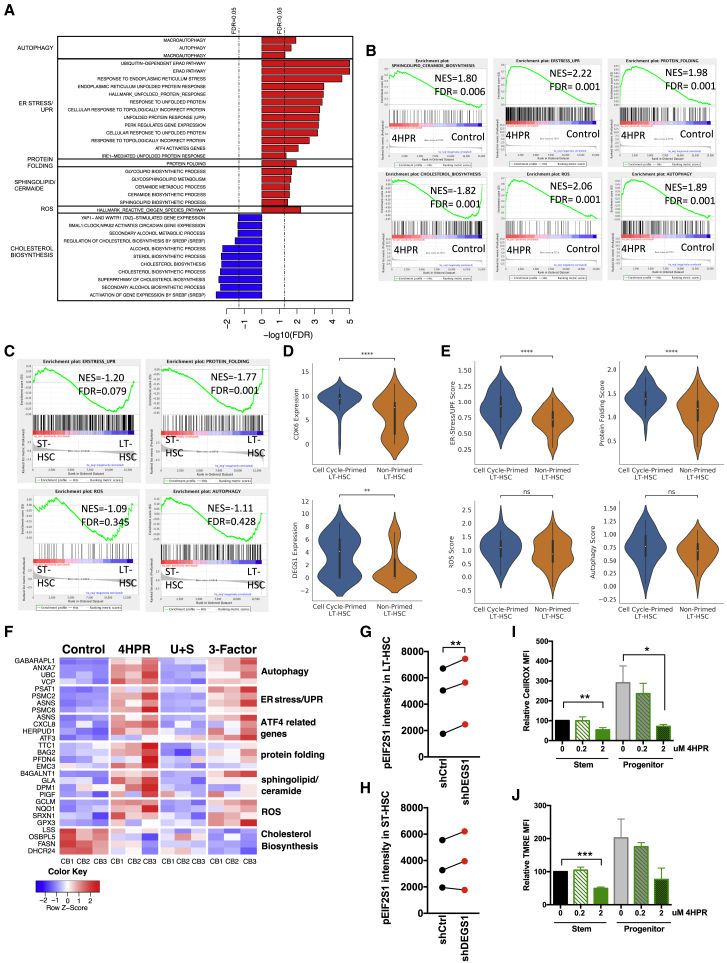
Sphingolipid Modulation with 4HPR Treatment Upregulates Cellular Stress Pathways and Remodels Cellular Metabolism in HSPCs during Ex Vivo Culture(A) NES scores for selected pathways that are significantly enriched following 4HPR treatment at day 2.(B) Pathway analysis (GSEA) of SpL/cer, cholesterol biosynthesis ER stress/UPR, protein folding, and ROS pathway modules for 4HPR compared to control.(C) GSEA analysis of autophagy, ER stress/UPR, protein folding, or ROS pathways in uncultured LT-HSCs versus ST-HSCs.(D and E) LT-HSCs from Velten et al. were clustered as cell cycle primed or non-primed as described in STAR Methods, (D) the gene expression of CDK6 (top) and DEGS1 (bottom), and (E) signature scores representing relative expression of pathways in (C) for single LT-HSCs; Wilcoxon rank sum test for (D) and (E); ∗p < 0.05; ∗∗p < 0.01; ∗∗∗p < 0.001; ∗∗∗∗p < 0.0001.(F) Heatmap showing gene expression at day 2 of the top 4 genes in gene sets in (A) organized as pathways. We included ATF4-related genes gene sets from the ER stress/UPR pathway.(G and H) Median pEIF2S1 staining intensity quantified from microscopy images for BFP+ (G) LT-HSCs and (H) ST-HSCs isolated from 4-week xenografts engrafted with shCtrl or shDEGS1 stem cells for 3 CBs (60 cells/CB, except shDEGS1 LT-HSCs, 13–17 cells/CB).(I and J) Flow cytometry analysis at day 2 post-treatment with indicated concentrations of 4HPR in the progeny of CD34+CD38− stem or CD34+CD38+ progenitor CB cells from 4 CBs for (I) ROS with CellROX and (J) mitochondrial membrane potential with TMRE.Paired t test; ∗p < 0.05; ∗∗p < 0.01; ∗∗∗p < 0.001 in (G)–(J).